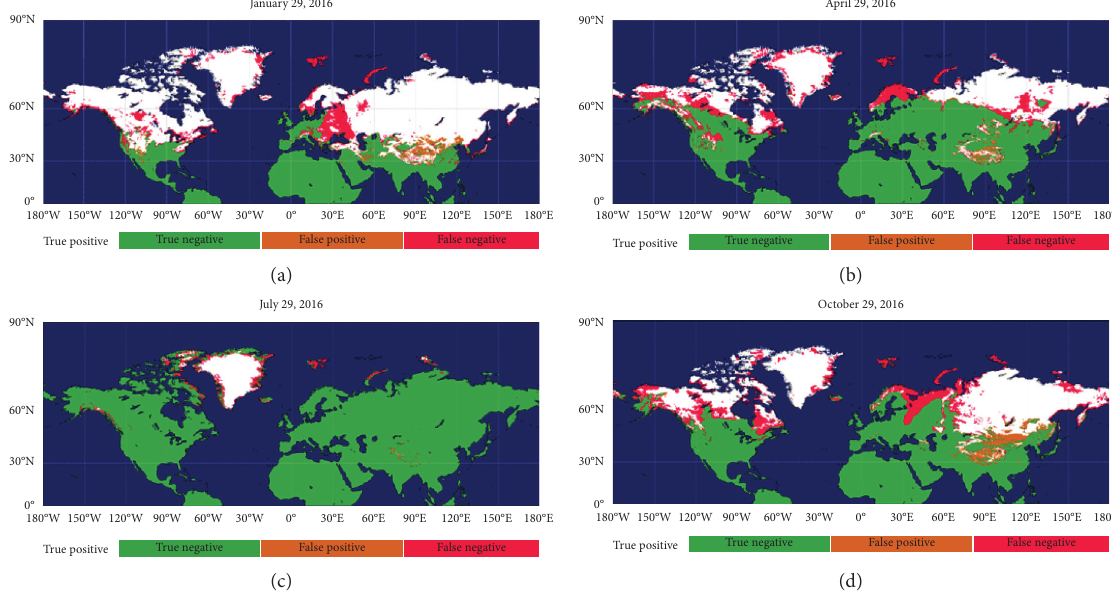
Figure 6: MSPPS vs IMS maps showing the classifications of the comparison on 29th of January, April, July, and October of 2016, respectively. Red color-product misses snow or underestimates snow cover.